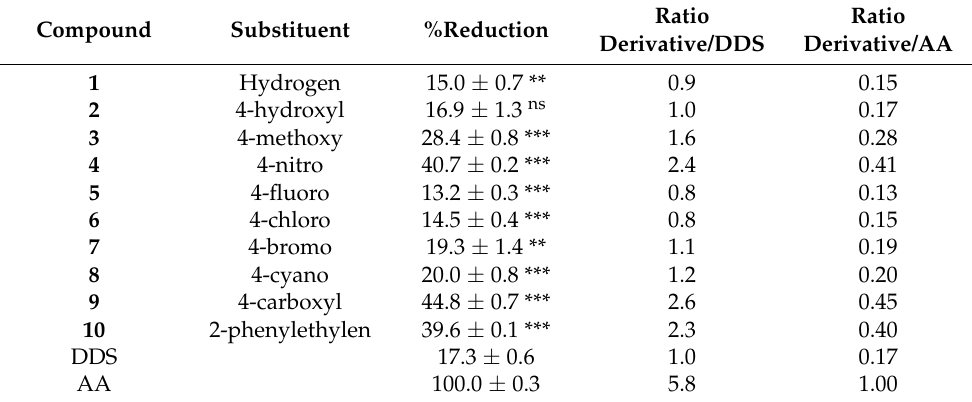
Table 3. Percentage of the reducing effect and correlation with DDS and ascorbic acid.